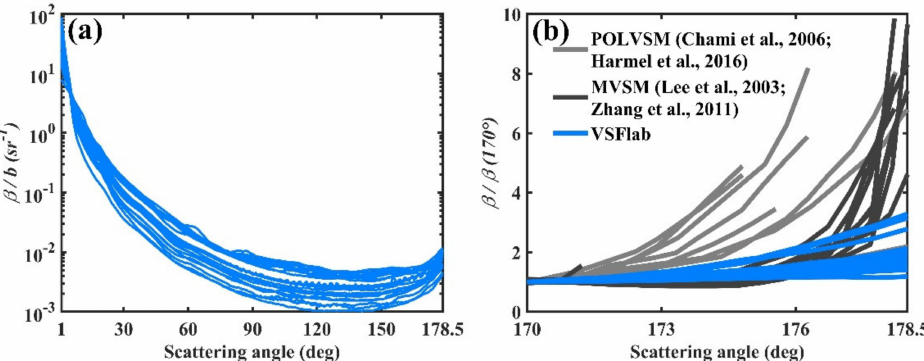
Figure 8. ( a ) Phase functions at 532 nm between 1 ◦ and 178.5 ◦ in the ECS. ( b ) Comparison of VSFs at 532 nm measured by VSFlab, POLVSM and MVSM between 170 ◦ and 178.5 ◦ . All these VSFs were normalized at 170 ◦